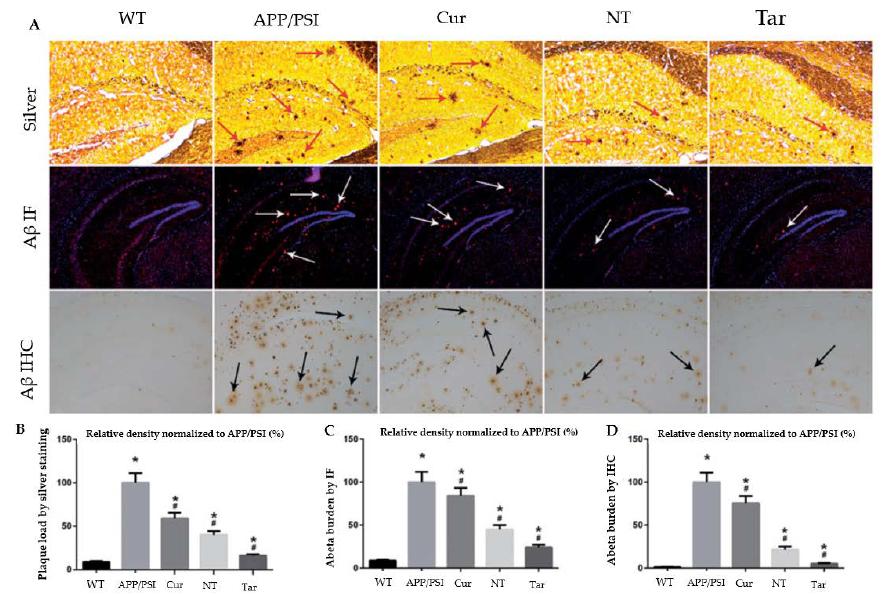
Figure 6. Capacity of Cur-loaded PLGA-PEG-B6 nanoparticles to decrease hippocampal A β burden in APP/PS1 mice. The AD animal model (APP/PS1) received saline, free Cur drug, PLGA-PEG/Cur nanoparticles (NT), and PLGA-PEG-B6/Cur nanoparticles (Tar), after which ( A ) Bielschowsky silver staining (red arrows) and immunofluorescence (IF, white arrows) or immunohistochemistry (IHC, black arrows) of A β in brain sections were performed. ( B – D ) The relative density of A β plaque in each group was compared using silver staining, A β IF, and A β ICH, respectively. The experimental findings show A β plaque deposition in APP/PS1 animals compared with wild-type mice. The Cur and NT groups experienced a marginal reduction, whereas the Tar group showed the most substantial reduction in A β plaques. (* p < 0.05; # p < 0.05) Adapted with permission from [76] under Open Francis